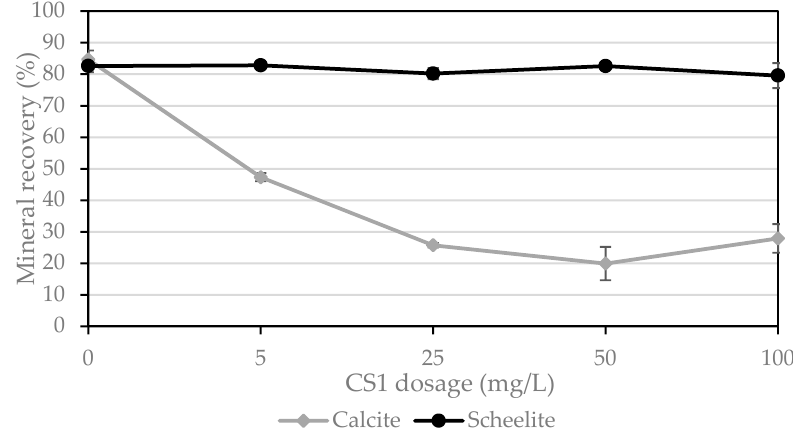
Figure 1. Single-mineral flotation recovery of calcite and scheelite depending on the Levasil CS30-324P ® (CS1) dosage (at pH = 8, collector = 1 × 10 − 4 sodium oleate, error bars represent the 95% confidence interval).